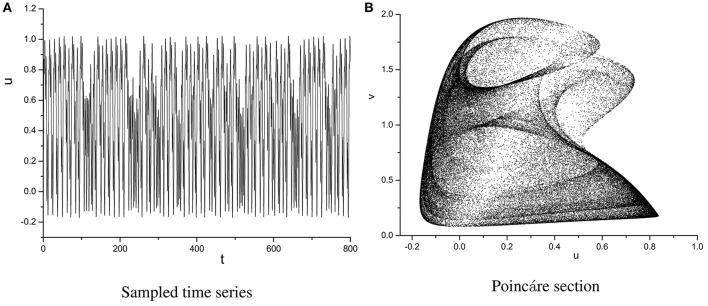
Sampled time series (A) and its Poincáre section (B) as ω = 2.0.